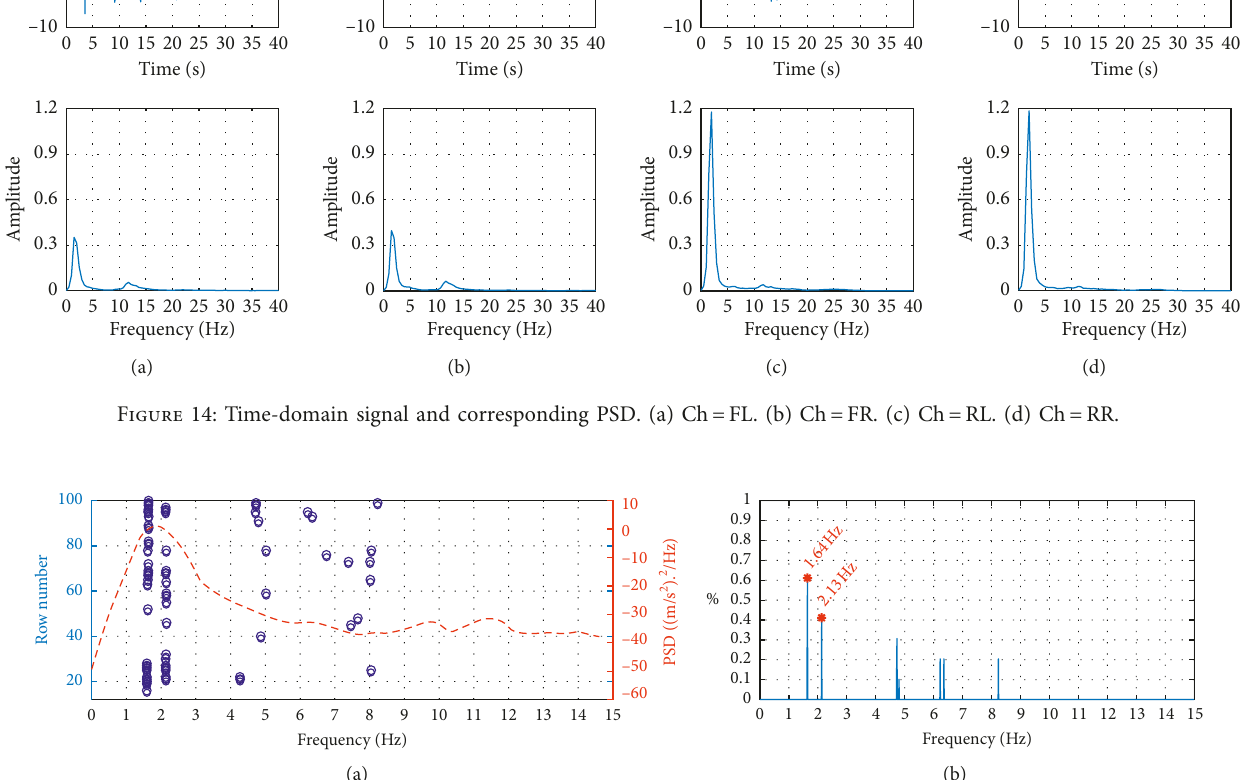
Figure 15: Stabilization diagram identified by ACS-SSI. (a) SD of ACS-SSI. (b) Selecting modes by the rate of the frequency over orders for on road vehicle modal